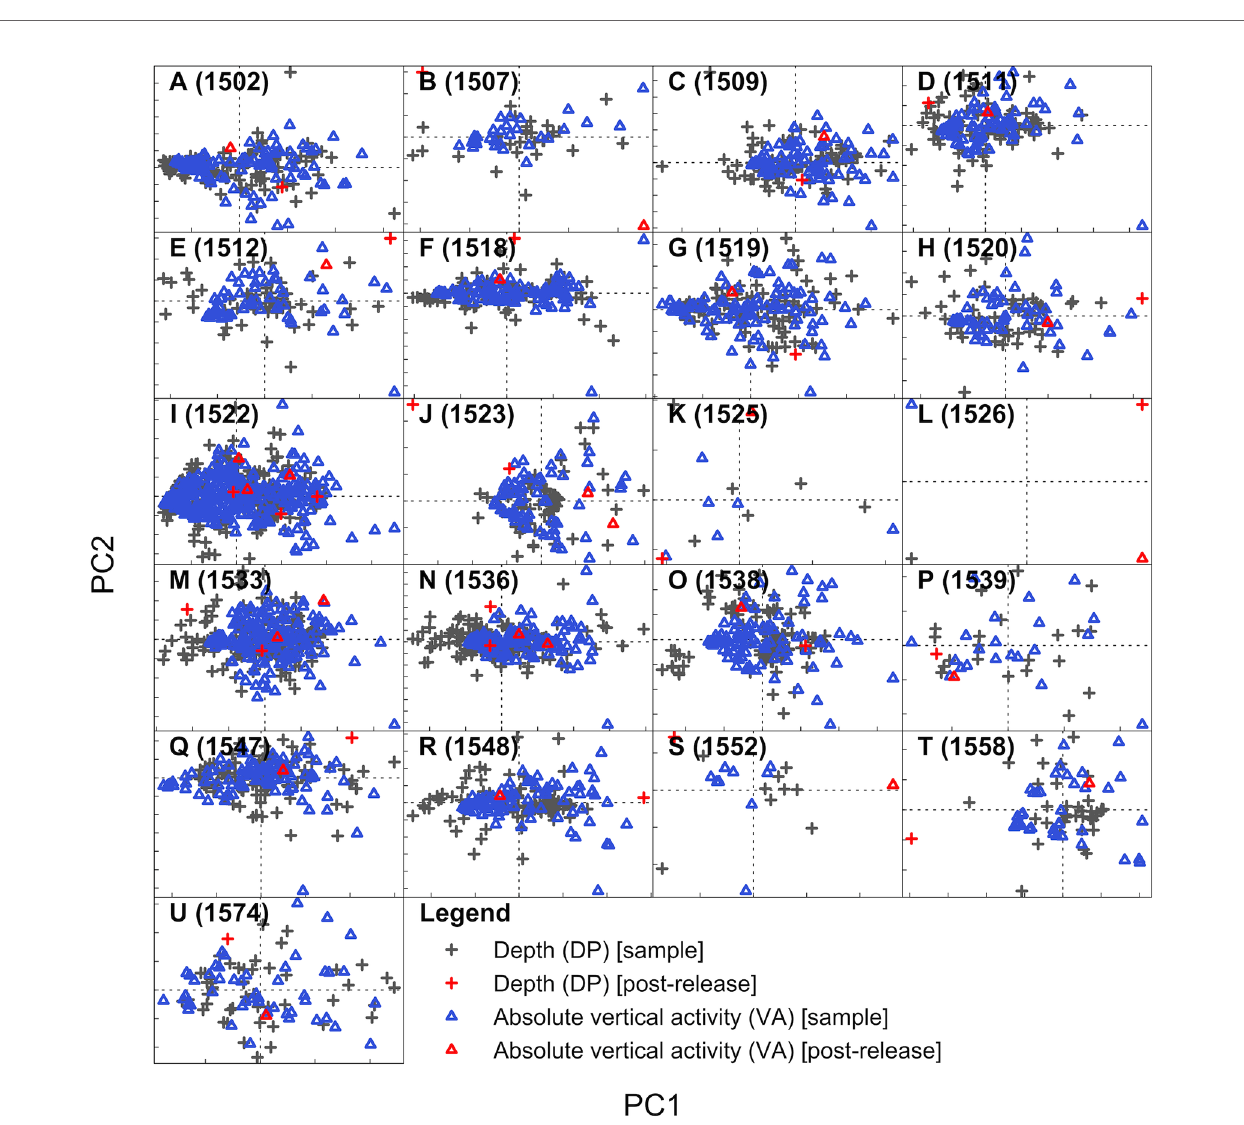
FIGURE 6 | Functional principal component analysis (FPCA) scores for post-release and ‘ undisturbed ’ depth and absolute vertical activity time series samples. Following the order of Figure 4 , each plot shows the scores for a speci fi c individual from FPCA of the (i) depth and (ii) absolute vertical activity time series, with ‘ undisturbed ’ samples shown in grey and blue, respectively, and post-release time series (following tag deployment and recreational angling, if applicable) shown in red. Note that the number of ‘ undisturbed ’ samples varies among individuals due to variation in individuals ’ time at liberty. All scores are centred and scaled to facilitate comparisons. The dashed horizonal and vertical lines mark adjusted scores on principal component 1 (PC1) and principal component 2 (PC2) of zero. Tick marks (bottom and left for each plot) are spaced one unit apart. The relative placement of scores for different samples indicates distinctness. For PC1, the proportion of the variability explained by FPCA ranged between 0.470 – 1.000 (median = 0.662) and 0.142 – 1.000 (median = 0.262) for the depth and absolute vertical activity time series respectively; for PC2, the proportions ranged between 0.000 – 0.298 (median = 0.124) and 0.000 – 0.246 (median =